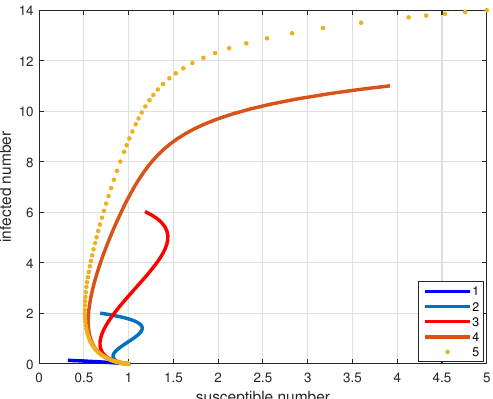
Figure 4. The phase portraits of I vs. S for system (1). The five trajectories correspond to different initial conditions and R 0 = 0.1087 <